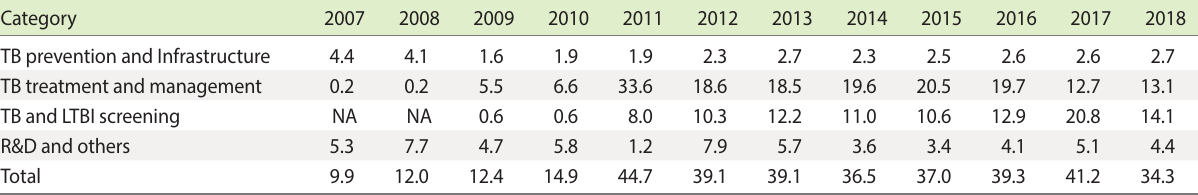
Table 1. TB budgets of central government by year Category